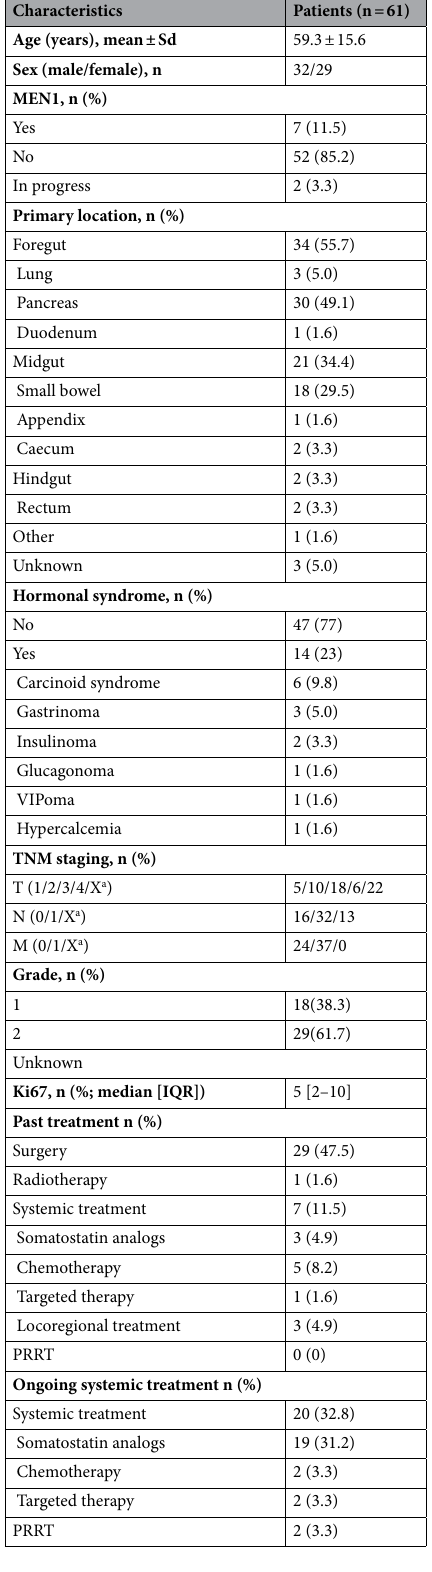
Table 1. Characteristics of patients. a Not available or